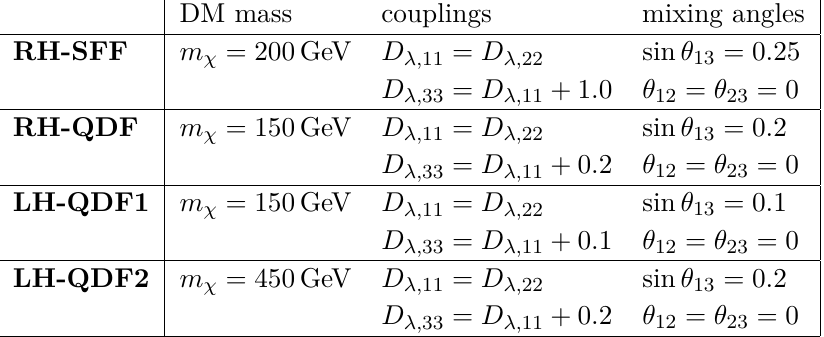
flavours χ , which in the DMFV framework is generated by the flavour non-universality i